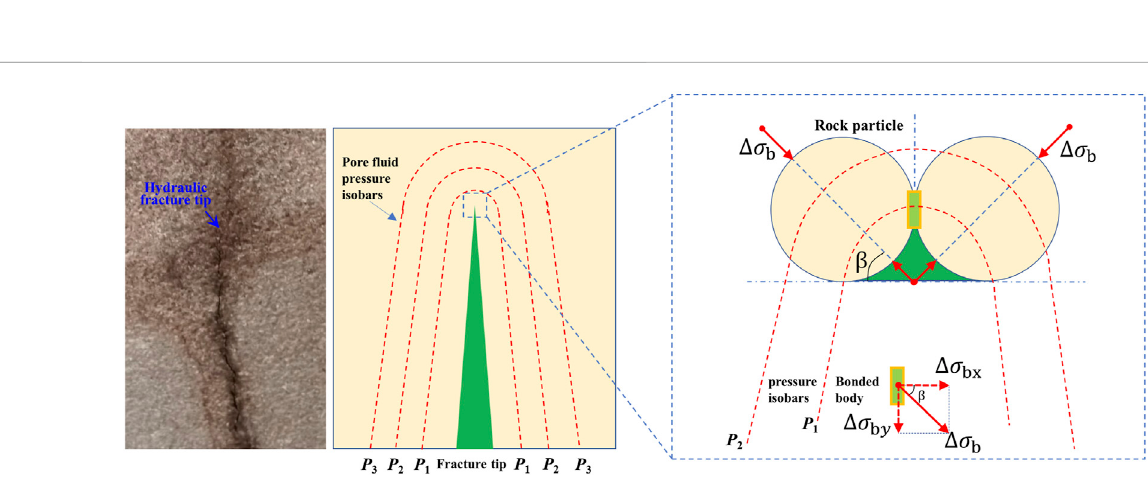
FIGURE 5 Schematic diagram of the stress on the rock unit at the crack tip: the additional stress increment required on the crack tip binder due to the water pressure gradient effect.